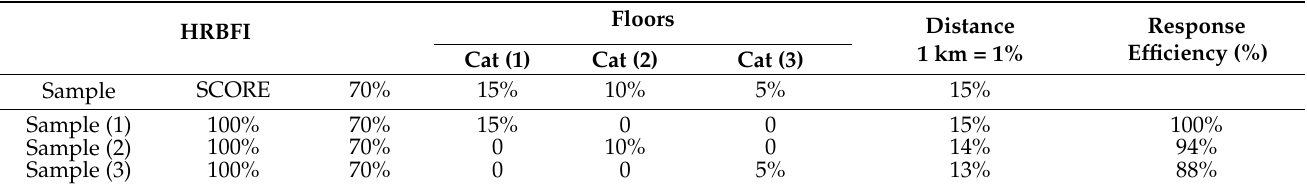
Table 7. Response calculation sample.